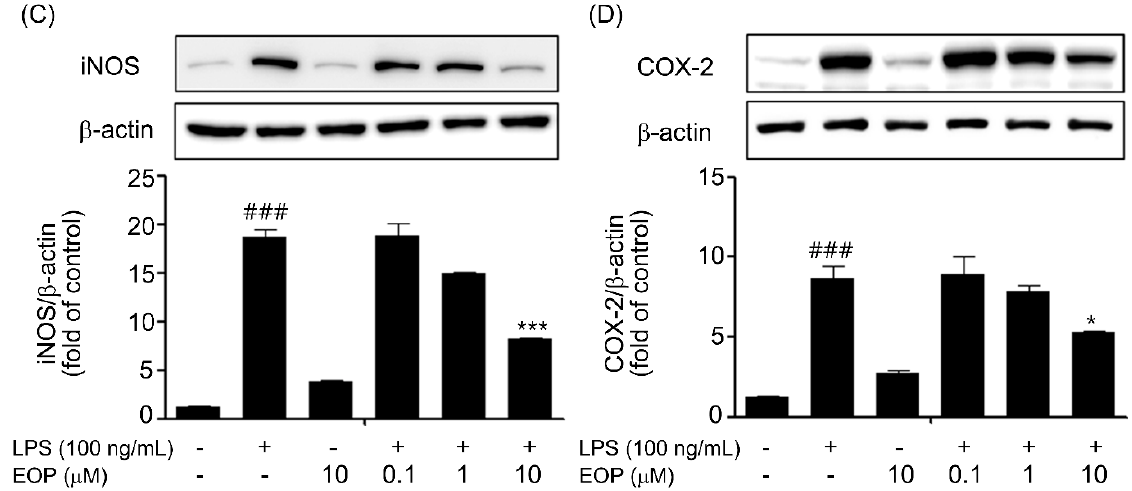
Figure 4. EOP attenuates pro-inflammatory cytokine gene expression in